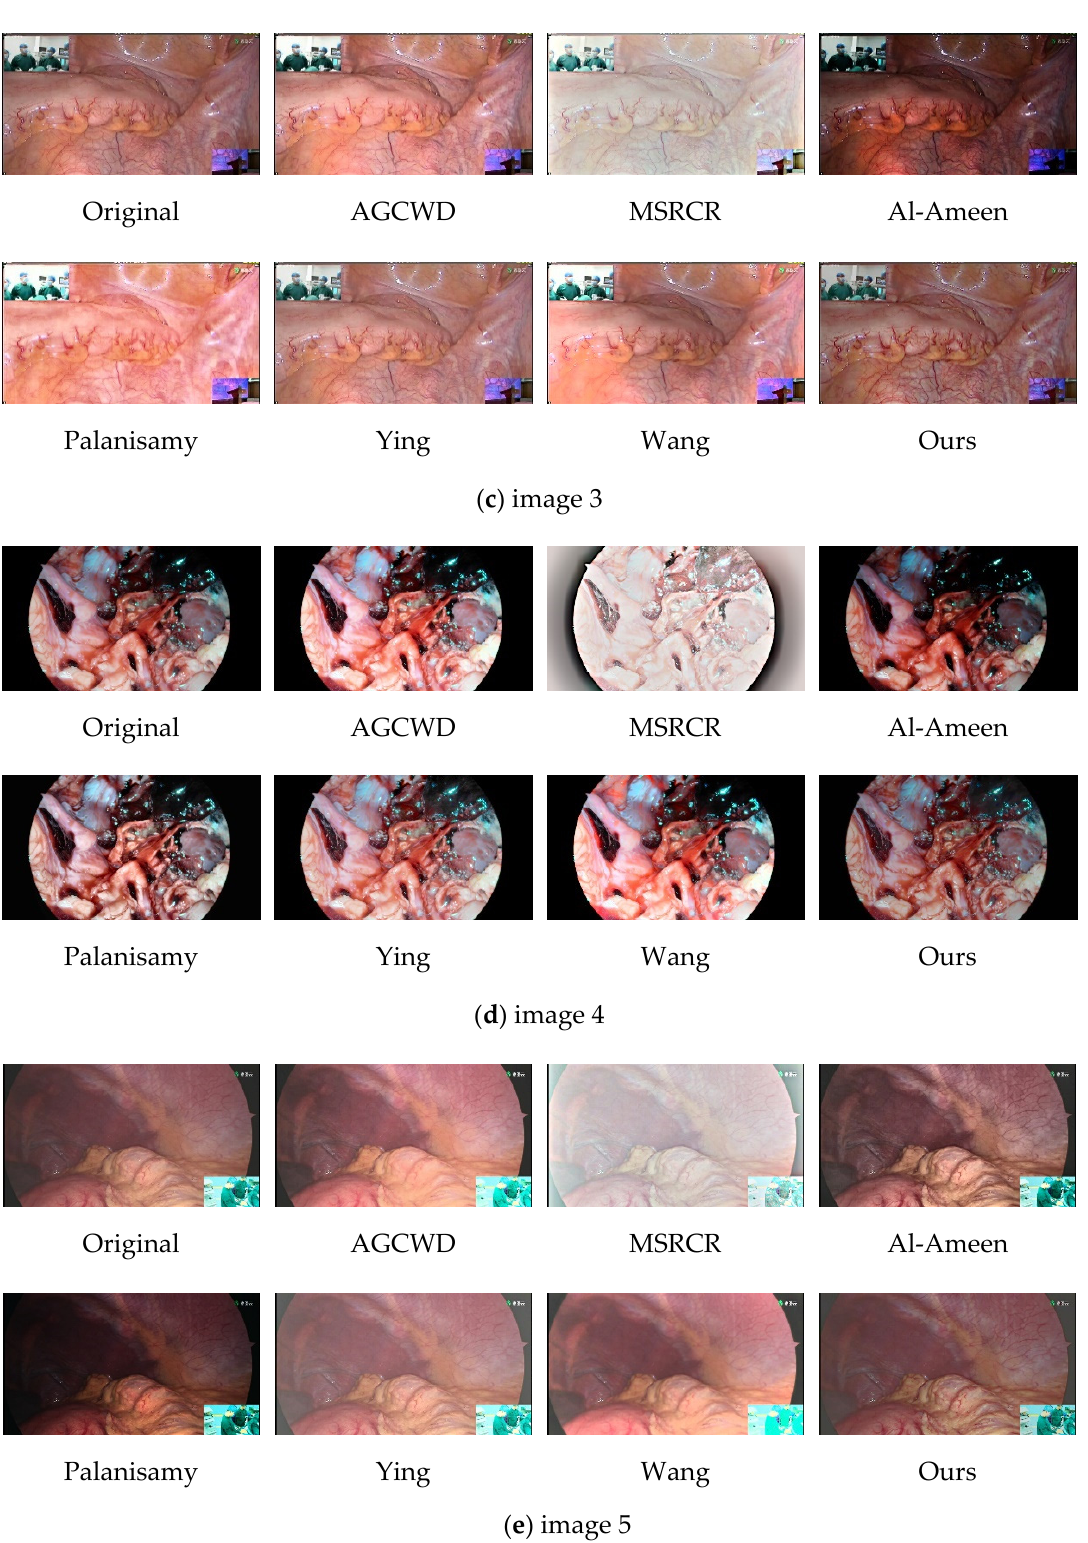
Figure 10. Comparison image of different algorithms. Five images ( a – e ) of different parts (including internal tissue maps of humans and chicks) were selected and the images were enhanced by classical image enhancement algorithms and novel medical image enhancement algorithms, and then shown in subjective comparison with the algorithms in this paper.